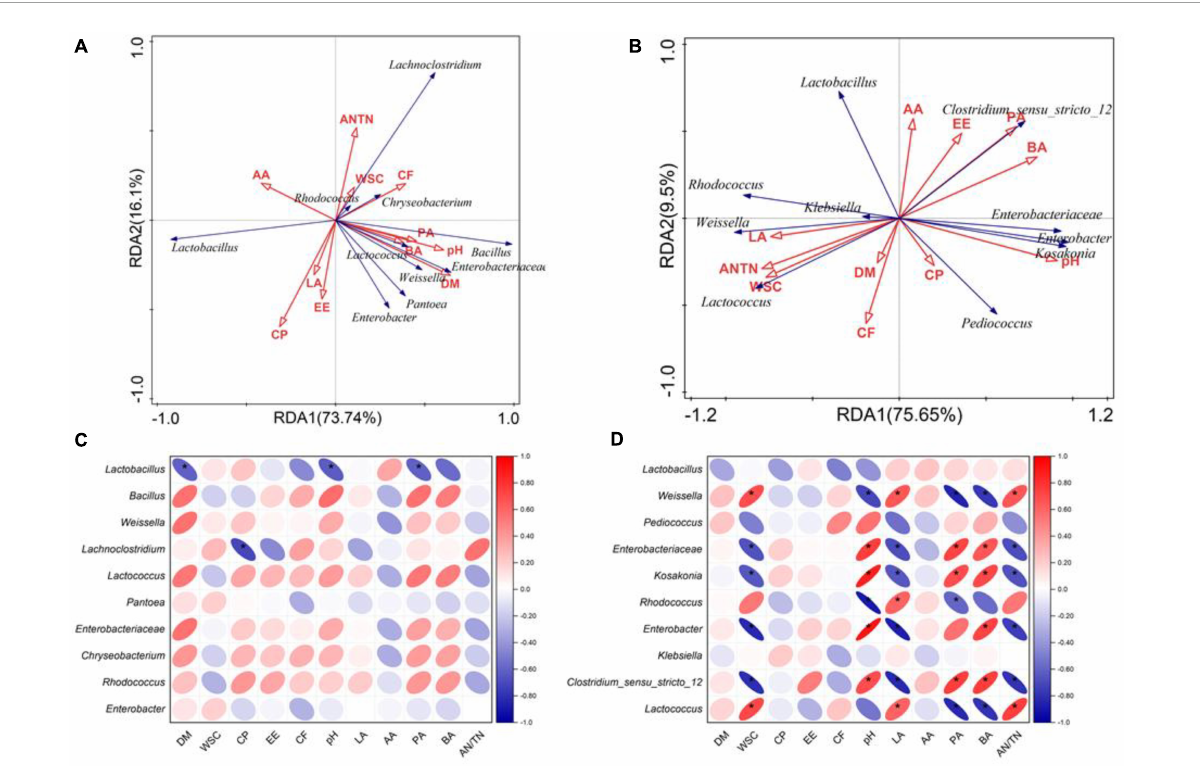
FIGURE4 The RDA plots showing the effects of chemical composition and fermentation products on the bacterial community structure at the genus level at flowering (A) and maturing stage (B) . Spearman correlation heatmap showed the relationship between bacterial classification at the genus level at flowering (C) and maturing stage (D) , and environmental variables (chemical composition and fermentation products). * indicated the level of significance at p < 0.05. AA, acetic acid; AN/TN, ammonia-N in total N; BA, butyric acid; CF, crude fiber; CP, crude protein; DM, dry matter; EE, ether extract; LA, lactic acid; PA, propionic acid; WSC, water-soluble